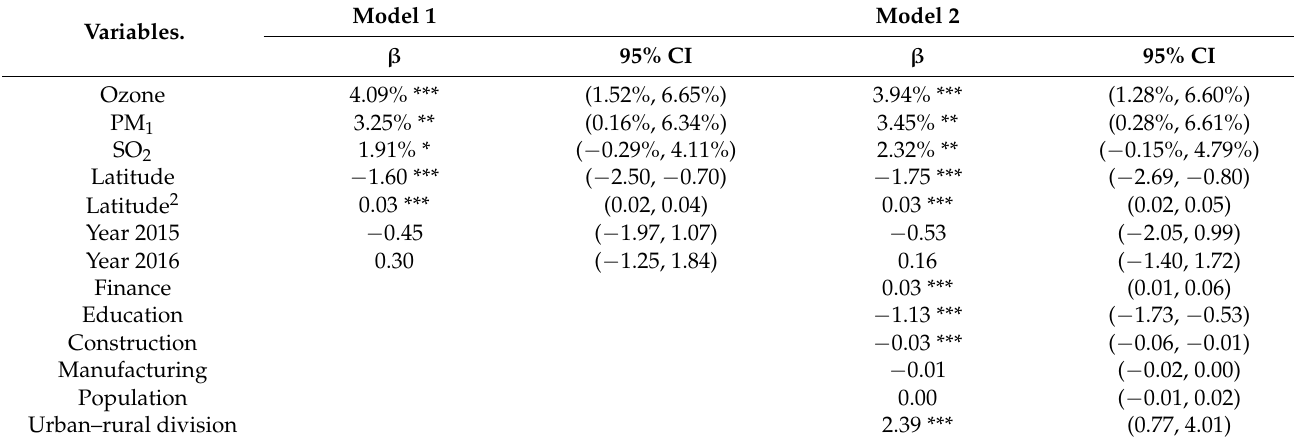
Table 5. Sensitivity analysis of estimating effects of ozone, PM 1 and the additional air pollutant (i.e., SO 2 ) in the same model. Variables.